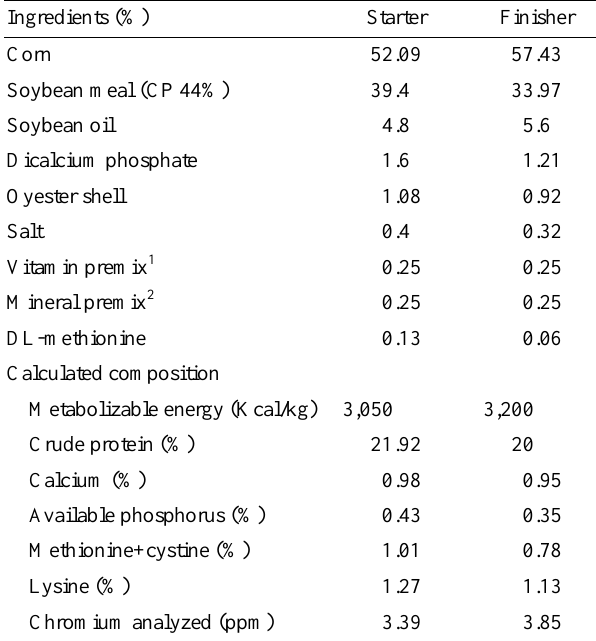
Table 1. Ingredients and chemical composition of the starter and finisher basal